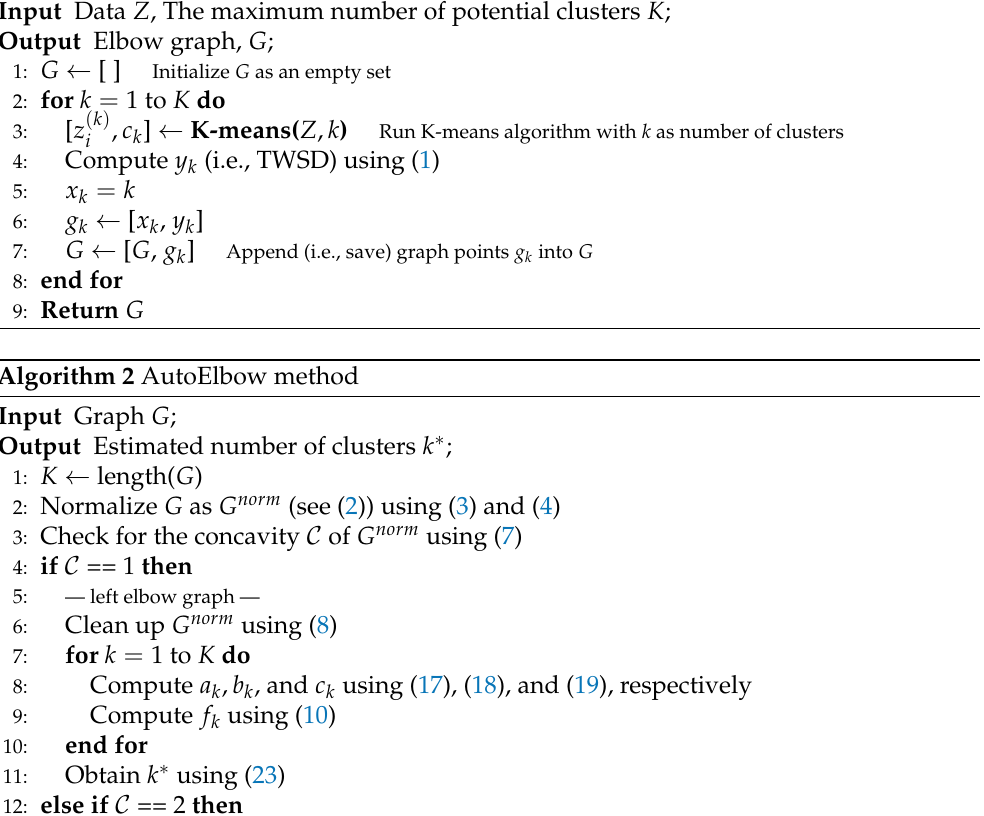
Algorithm 1 Generate elbow graph G